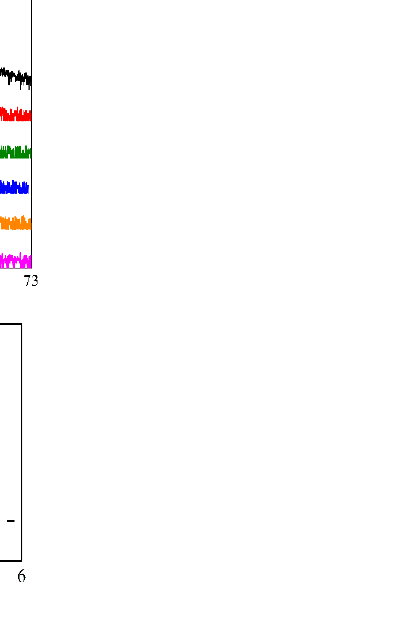
Figure 5. ( a ) 2Theta-Omega scans and ( b ) corresponding calculated lattice parameters of out-of-plane (11–22) plane when the 1000 nm-thick samples are annealed under different durations.